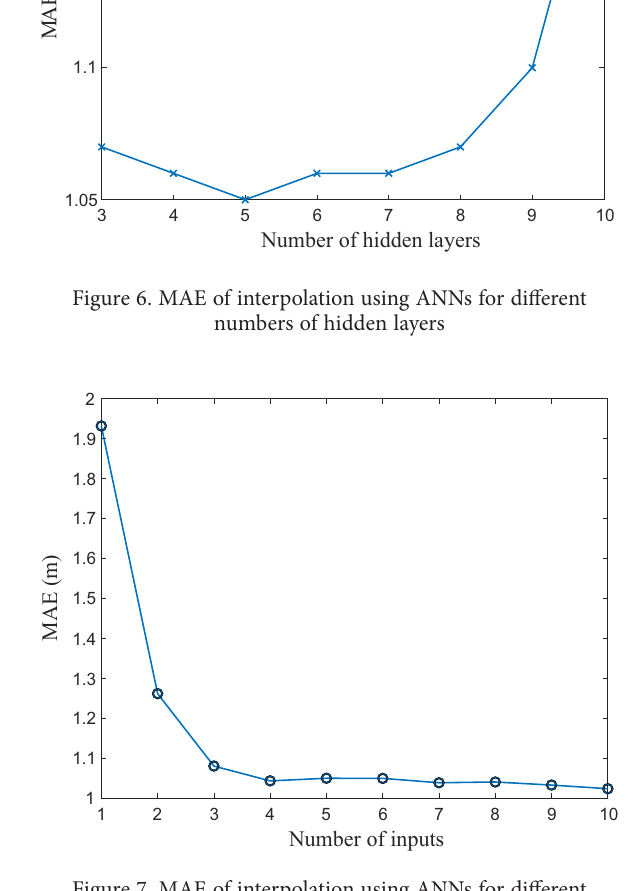
Figure 7. MAE of interpolation using ANNs for different numbers of